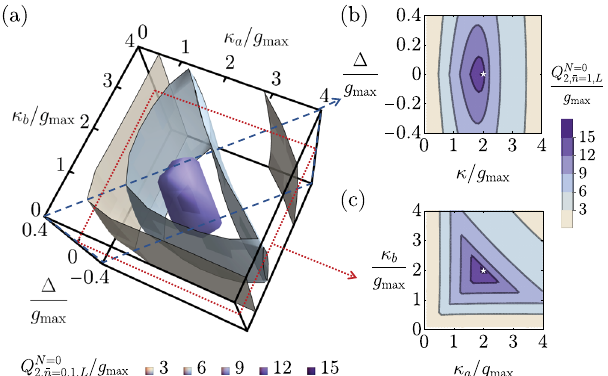
Fig. 9 | Diagramsfor thenumericalsearch oftheoptimized0-stagetransducer parameters that can attain the highest possible continuous-time two-way thermal-loss quantum capacity lower bound with a mean thermal photon -- n = 0 : 1. a Contour plot of the continuous-time two-way thermal-loss number capacity lower bound for N =0, Q N =0 2, (cid:2) n =0 : 1, L , in the parameter space of κ a , κ b , and − Δ Δ ≡ Δ a b . b Asliceintheparameterspacewithsymmetricexternalcouplingrates κ κ κ . The white star represents the location of the maximally fl at parameters. a = b = c A slicein theparameter space under the resonant condition Δ =0.The white star represents the location of the maximally fl at